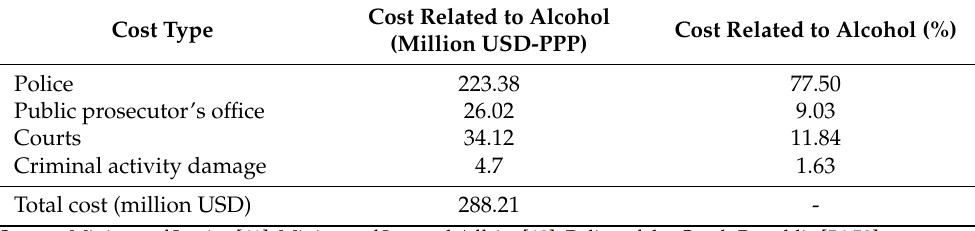
Table 9. Law enforcement cost in million USD, 2017.